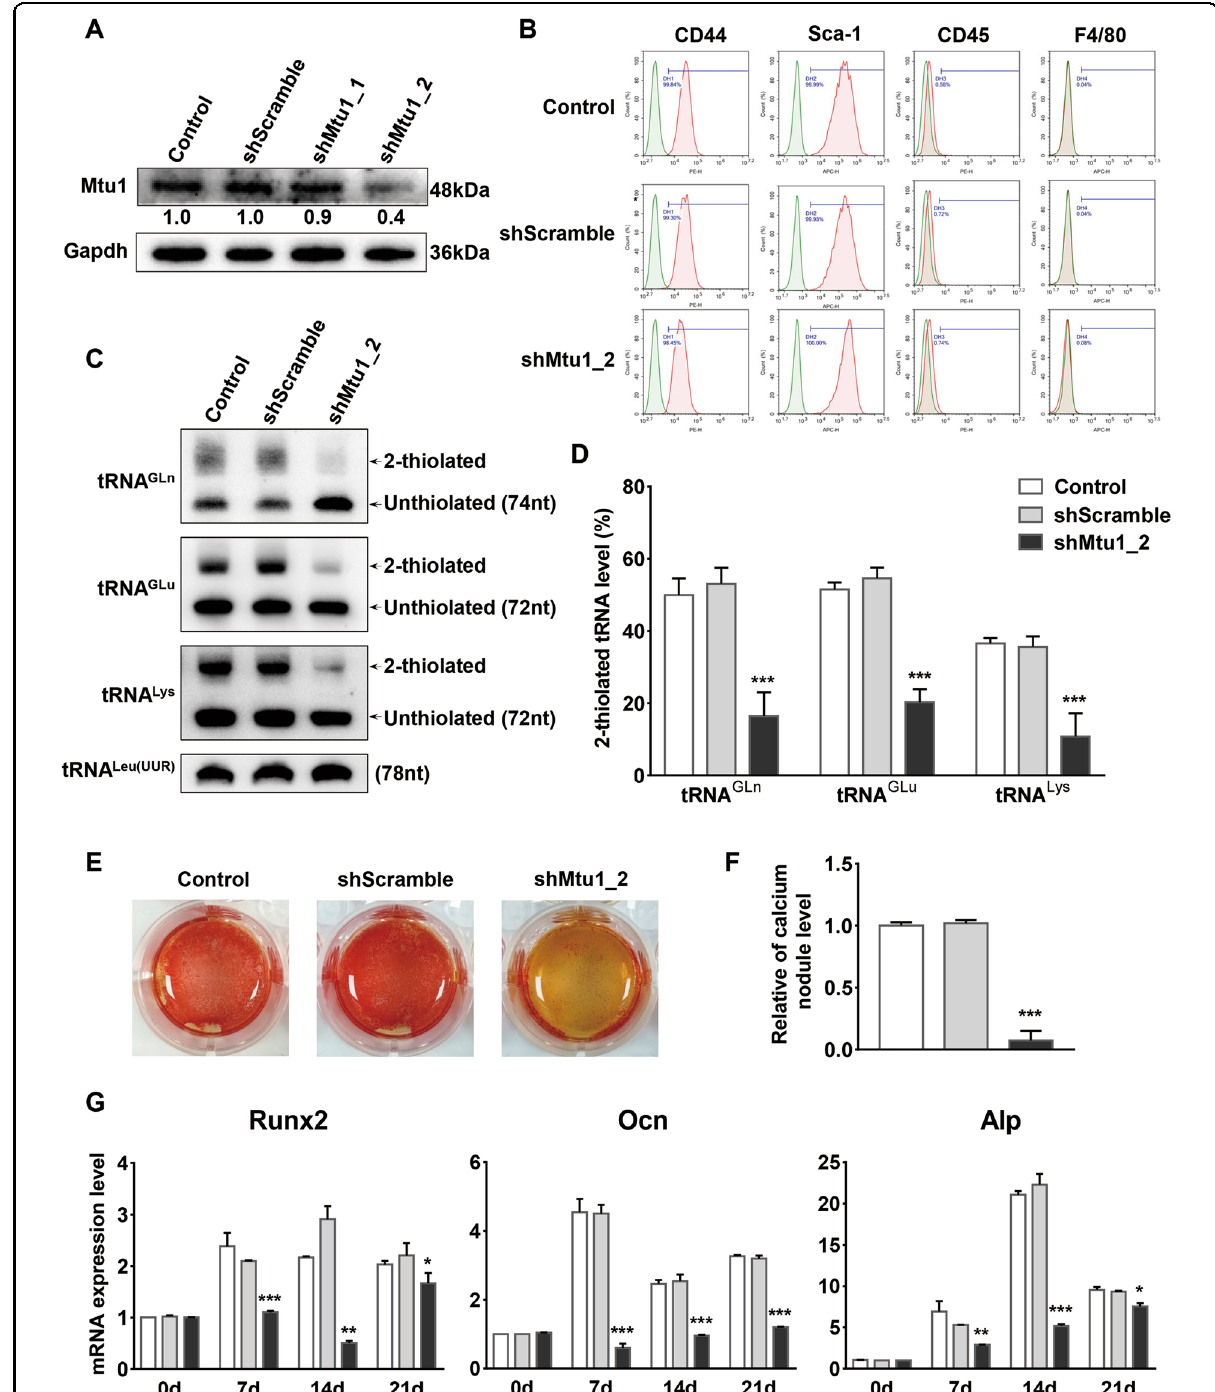
Fig. 5 Mtu1 knockdown reduced the mitochondrial tRNA 2-thiouridylation level in MS5 stromal cells. A Mtu1 was silenced in MS5 stromal cells using distinct Mtu1 shRNA-encoding lentivirus or scramble lentivirus. Western blot analyses show lower Mtu1 expression levels in shMtu1_2 cells. B Flow cytometric analysis for cell-surface markers. Green peaks, isotype control; red peaks, speci fi c antibodies. C 2-Thiouridylation level analysis of mt-tRNAs by APM gel. D Proportion of tRNA 2-thiouridine modi fi cation levels. The proportion values are expressed as ratios (%) of the average of 2- thiouridine modi fi ed tRNA levels to total levels. E , F Alizarin Red S staining and quanti fi cation of mineralized calcium deposits in cells after 14 days of osteogenic differentiation. The fi gures show one representative result of at least three experiments. G RT-qPCR at 0, 7, 14, and 21 days for mRNA levels of osteoblast differentiation markers, including Runx2 , Ocn , and Alp . * P < 0.05; ** P < 0.01; *** P <